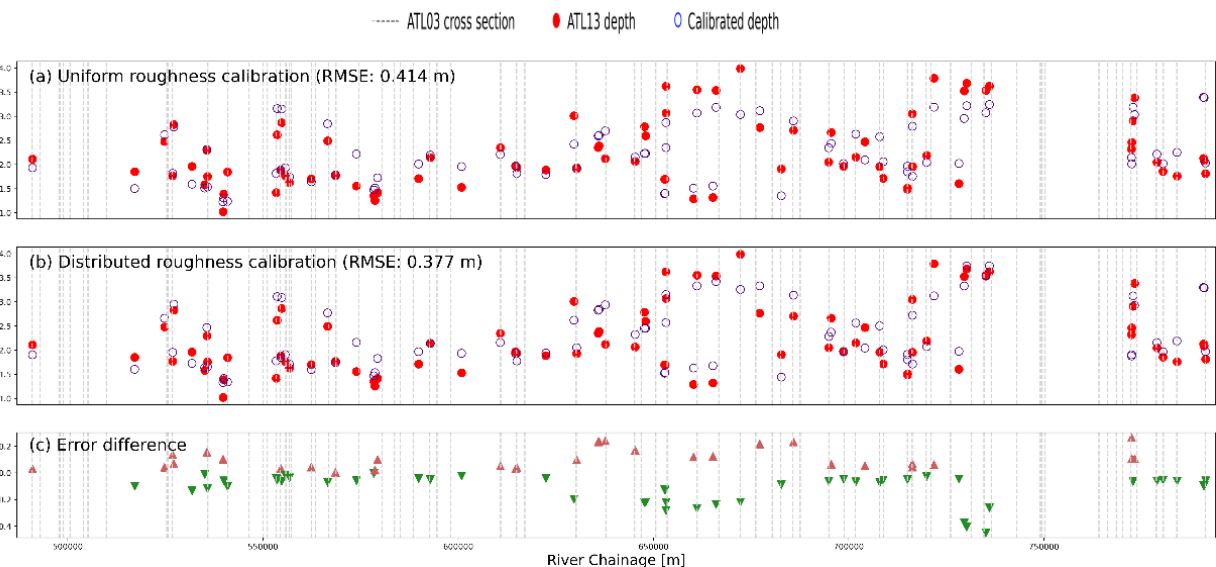
Figure A1. Uniform depth calibration (a) compared with the distributed roughness calibration for eight Manning’s roughness values (b) and the error difference between the uniform calibration and the distributed calibration (c) .